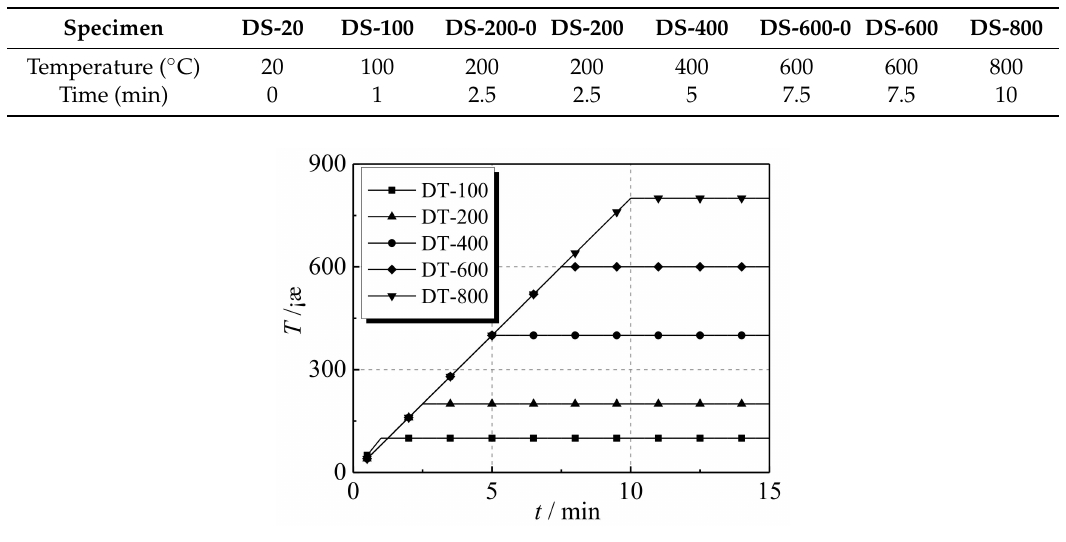
Figure 3. Heating curves of the